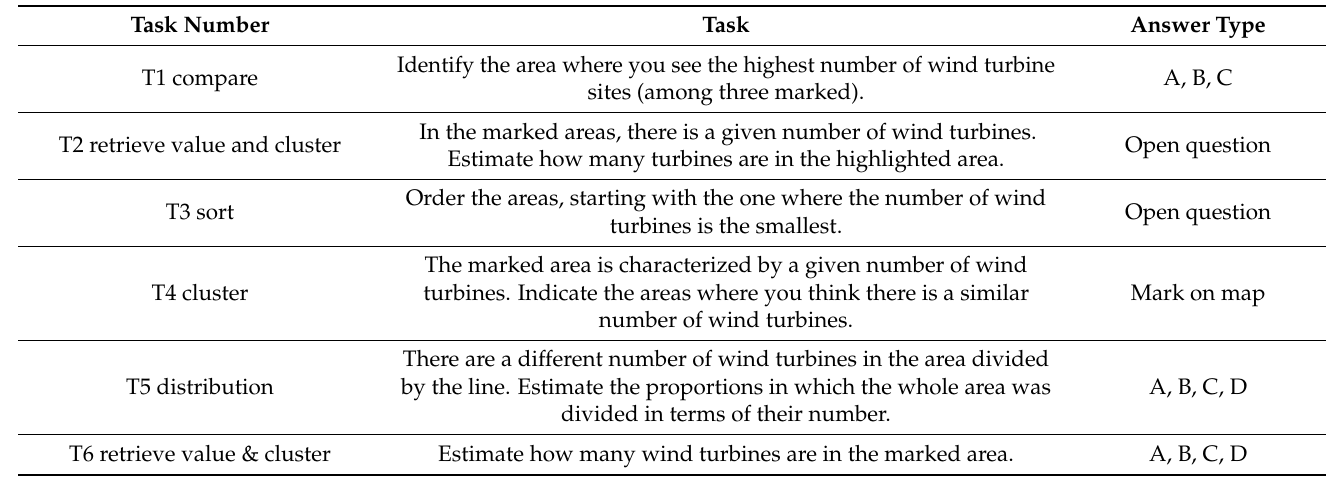
Table 2. Content of tasks, type of tasks, and answer types.